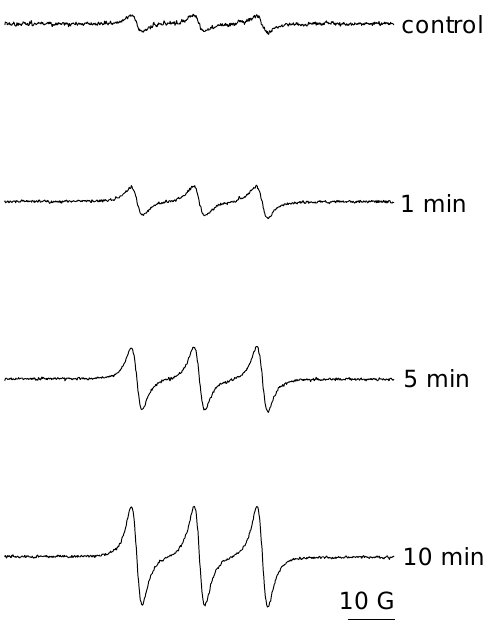
Figure 6. Generation of singlet oxygen from 4-nitropyrene. The sample containing 0.9 mM 4-nitropyrene and 20 mM 2,2,6,6-tetramethylpiperidine in 95% CH 420 nm, and ESR signal recorded after 1, 5, and 10 min exposure. Control did not contain any 4-nitropyrene. ESR instrument settings were as follows: 20 mW microwave power, 100 G sweep width, 1 G field modulation amplitude, and 100 kHz modulation